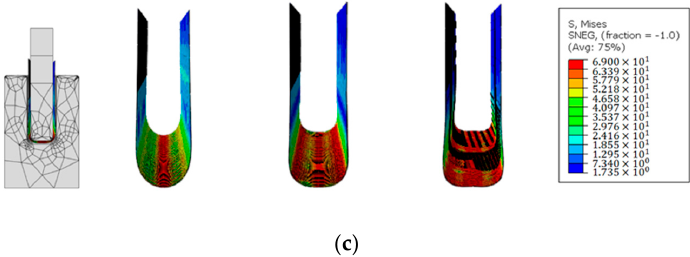
Figure 7. The comparison of effective stress according to R1 of die and R2 of the punch: ( a ) second stage—V angle of the blank became narrower; ( b ) third stage—U shape deformation; and ( c ) last stage—fin shape deformation.